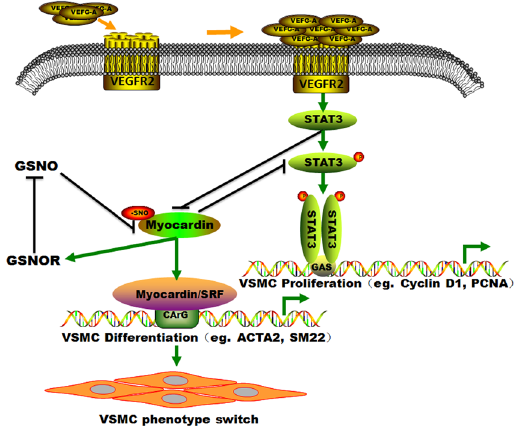
Figure 5. The model that Myocardin, GSNOR and GSNO created a negative feedback loop to regulate the VSMC phenotypic switch. Myocardin positively modulates expression of GSNOR, GSNOR, and then downregulates GSNO and meanwhile GSNO inhibits the contractile markers expression by Myocardin S - nitrosylation, thus creating a negative feedback loop to regulate the VSMC phenotypic